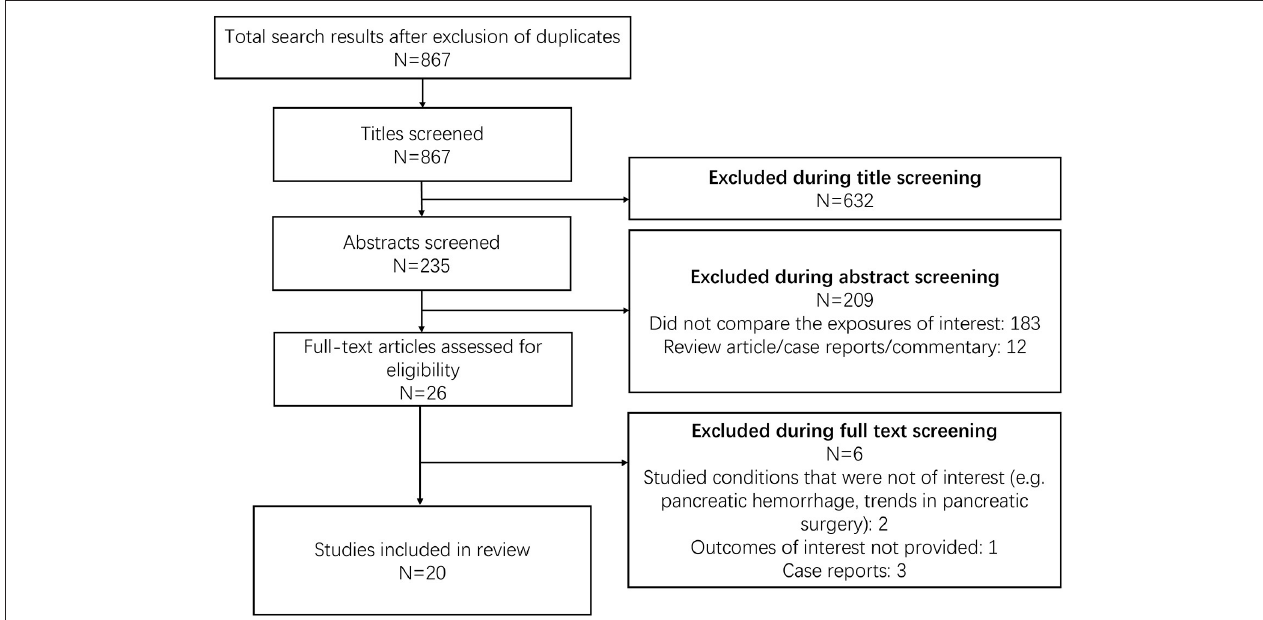
FIGURE 1 | Selection process of the studies included in the